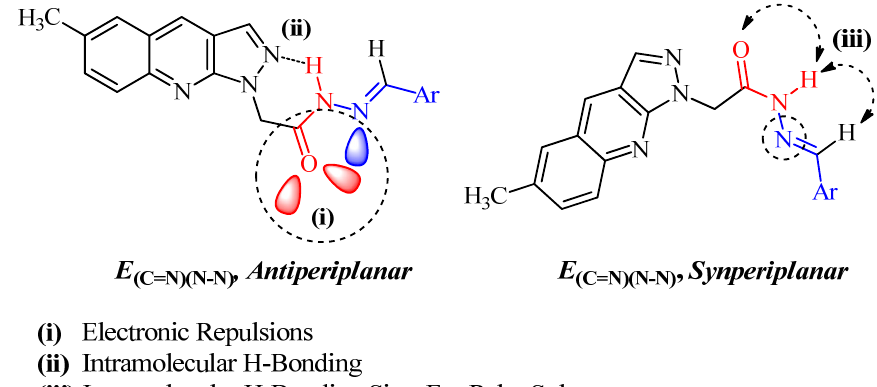
Figure 5. Possible interactions of E -Isomer in solution.